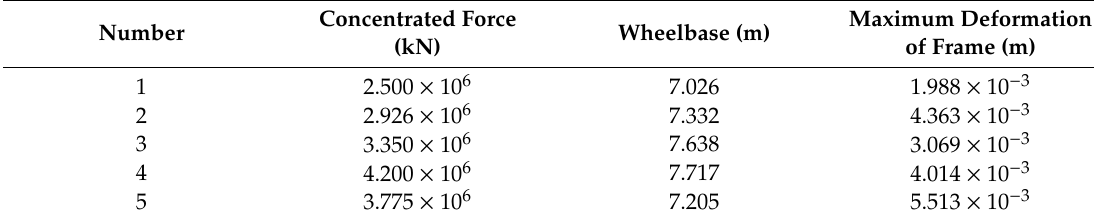
Table 4. Initial interval values under bending.